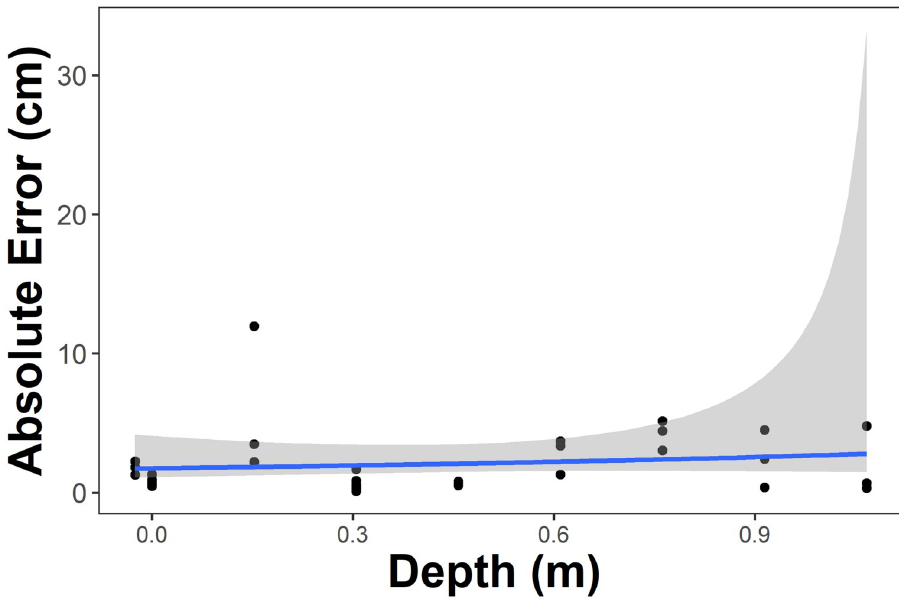
Fig 6. Relationship of absolute error of aerial SVC measurements and depth. The solid line and gray shaded area are the generalized linear regression and standard error, respectively. Depth measurements of < 0 indicate measurements made from the camera in the air only, just above the water surface.